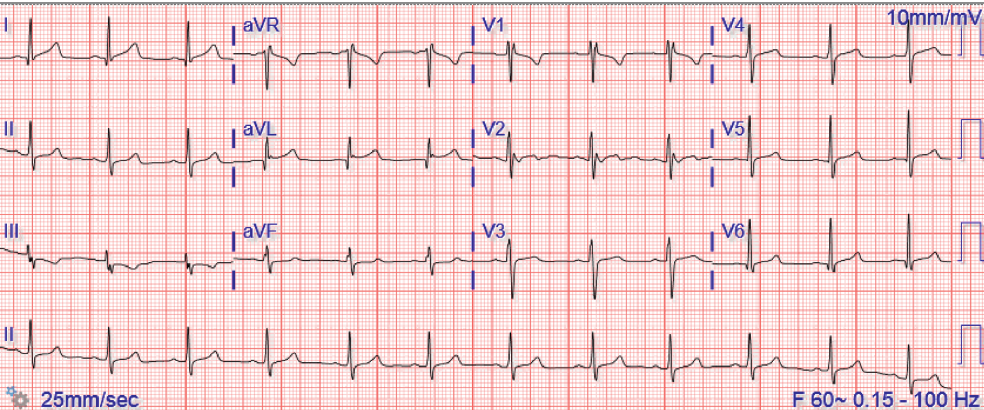
Figure 1: The patient’s EKG on admission, which demonstrates sinus rhythm with nonspecific STchanges in the lateral leads alongside T-wave inversions in lead III. There were no observed ST-segment elevations or ST-segment